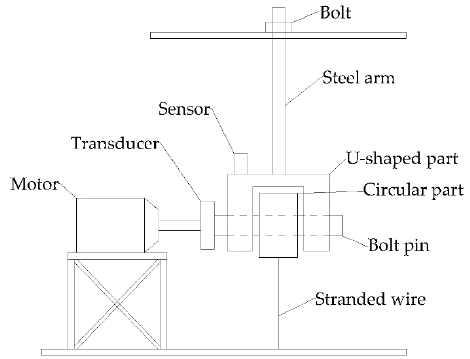
Figure 2. Schematic of the experimental setup.